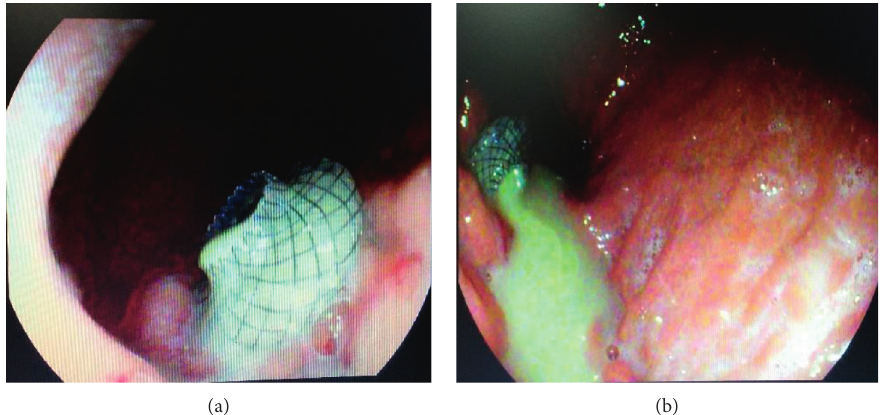
Figure 3: Endoscopic view showing AXIOS drainage of the